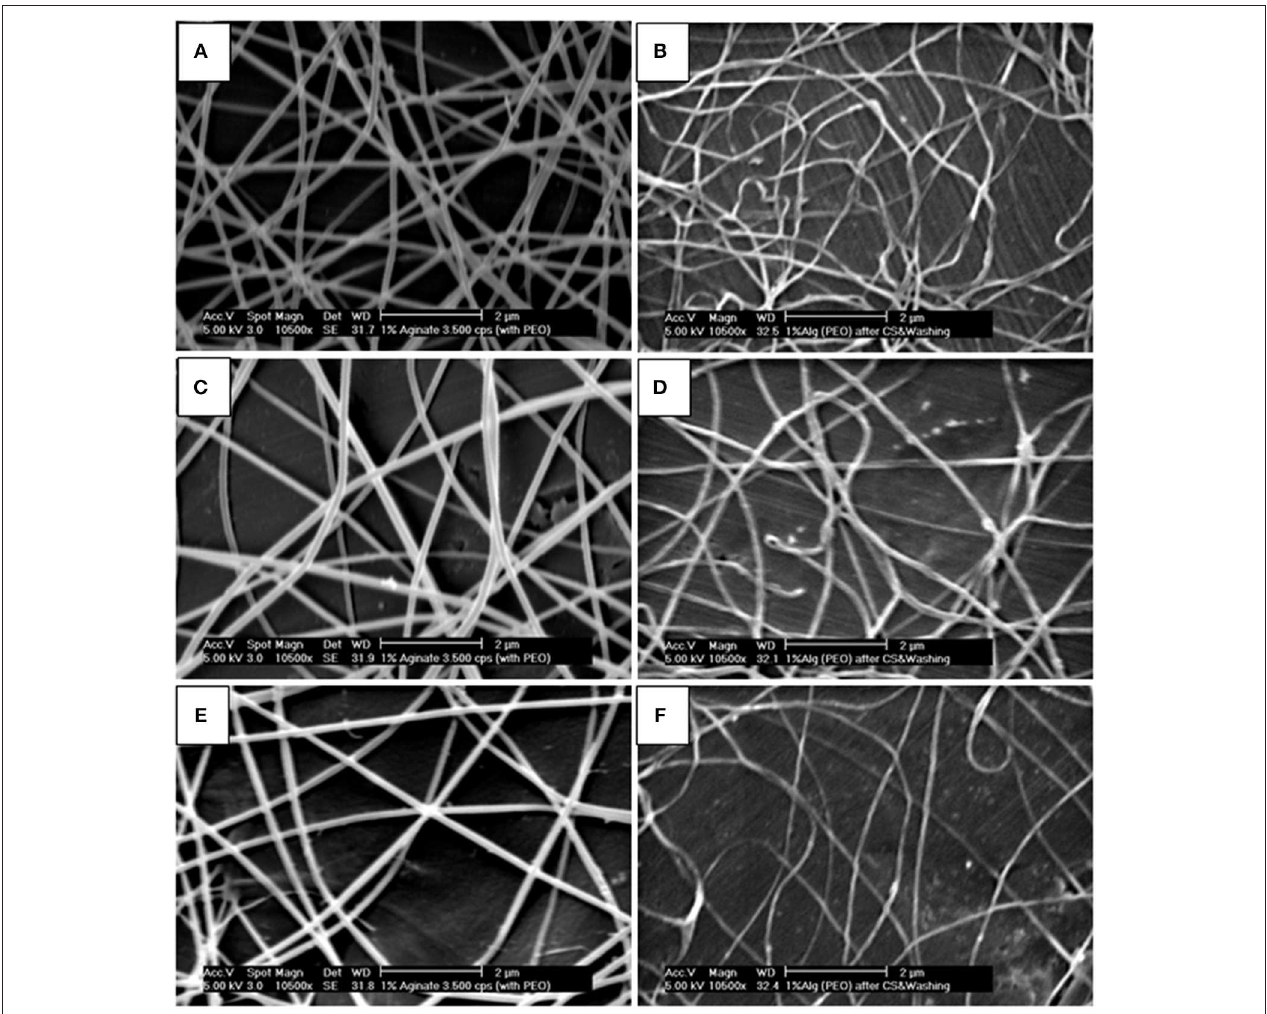
FIGURE 2 | SEM micrographs of 1% Alginate + 4% PEO electrospun scaffolds before and after “cross linking + washing”: (A) native scaffold, flow rate of 0.05 ml/h and air gap of 25cm; (B) sample “A” after cross linking and washing; (C) native scaffold, flow rate of 0.2 ml/h and air gap of 28.5cm; (D) sample “C” after cross linking and washing; (E) native scaffold, flow rate of 0.8 ml/h and air gap of 28.5cm; (F) sample “E” after cross linking and washing. Scale bar: 2 µ